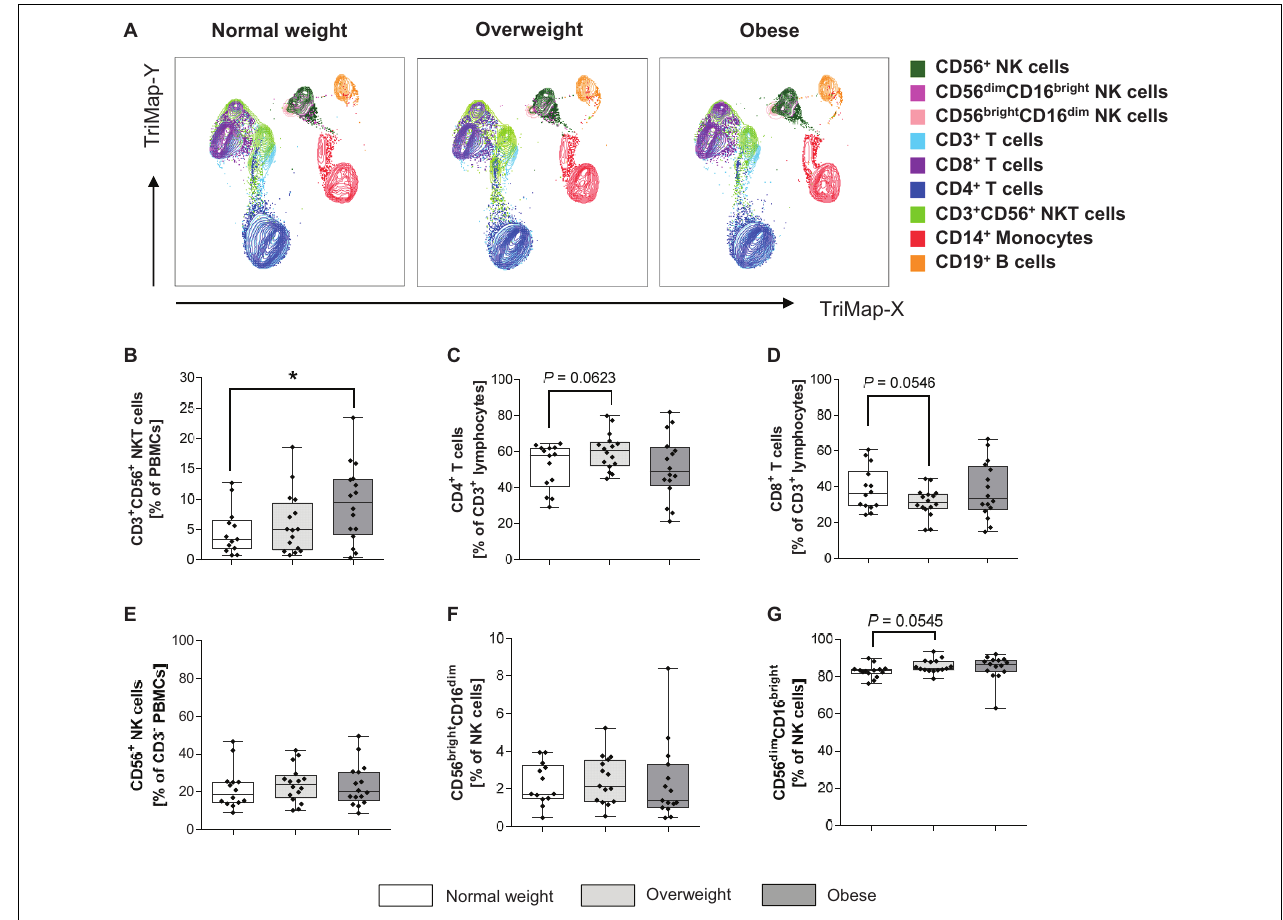
FIGURE 1 | Frequencies of immune cell populations in peripheral blood mononuclear cells (PBMCs) isolated from normal weight ( n = 14), overweight ( n = 16), and obese ( n = 16) healthy blood donors. (A) TriMap plots are presented showing the combined clusters of all donors subdivided into normal weight, overweight and obese. Clusters were identified by manual gating using the surface marker indicated on the legend. Percentage of CD3 + CD56 + natural killer T (NKT) cells (B) within viable PBMCs. CD4 + helper T lymphocytes (C) and CD8 + cytotoxic T lymphocytes (D) as percentages of CD3 + T lymphocytes. Percentage of CD56 + NK cells in CD3 - cells (E) . Percentage of CD56 bright CD16 dim NK cells (E) and CD56 dim CD16 bright NK cells (G) in NK cells. (B–G) Graphs are box and whisker plots with median ± minimum to maximum value; with additional dot plot representing individual donors. Overweight and obese groups were compared to normal weight control group. Statistical significance is indicated as: * P ≤ 0.05; exact P -values within 0.05 ≤ P ≤ 0.1 are indicated.